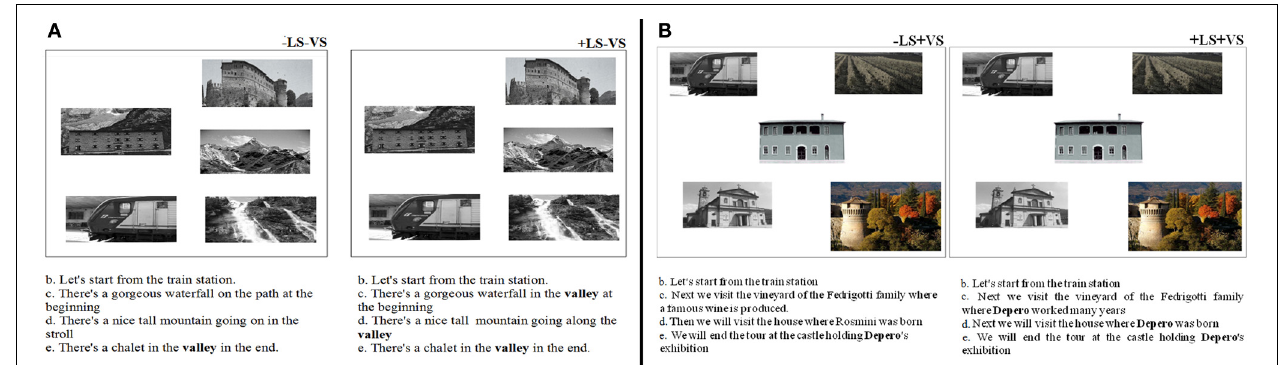
FIGURE 1 | Example of the experimental stimuli in − LS − VS and + LS − VS (A) and − LS + VS and + LS + VS (B) conditions. In − LS − VS and + LS − VS conditions the landmarks on the maps had all the same visual salience. In the − LS condition the sentences did not have any entity repeated. In + LS condition an entity (valley) was repeated. The last sentence (e.g. “there’s a chalet in the valley in the end”) was the same in both − LS − VS and + LS − VS conditions. In